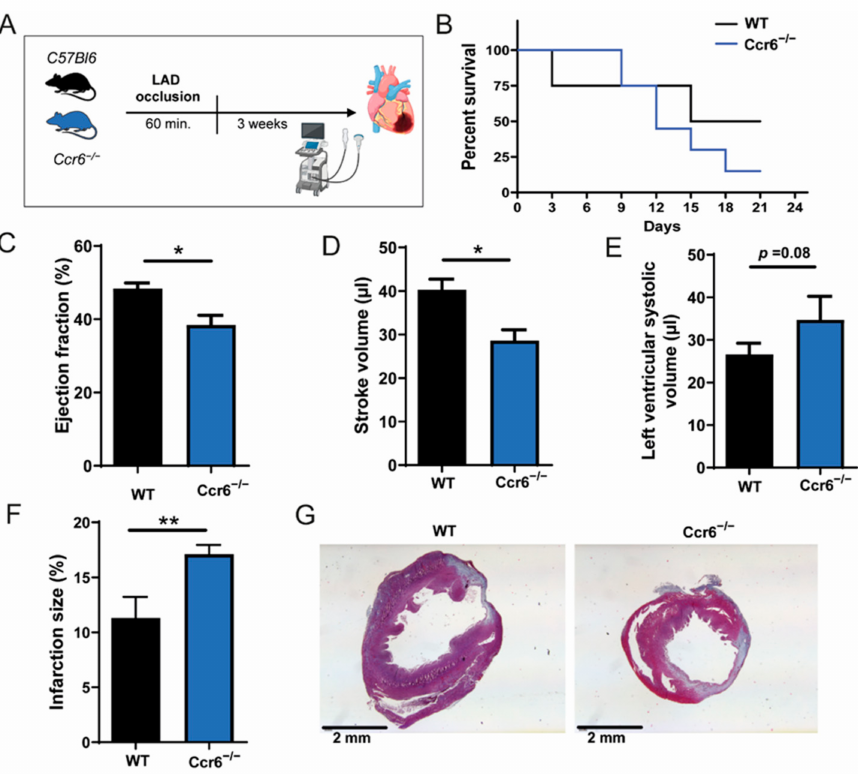
Figure 1. CCR6 deficiency results in decreased cardiac function and increased infarction size after ischemia-reperfusion injury. ( A ) Study design: wild-type and Ccr6 − / − mice were subjected to ischemia-reperfusion injury, echocardiography was performed 3 weeks after injury ( n = 3). Image was created using Biorender.com (Accessed on 2 September 2021). ( B ) Survival curve after ischemia- reperfusion injury. ( C ) Ejection fraction in Ccr6 − / − mice compared to wild-type controls. ( D ) Stroke volume in Ccr6 − / − mice compared to wild-type controls. ( E ) End-systolic volume in Ccr6 − / − mice compared to wild-type controls. ( F ) Infarction size in Ccr6 − / − mice compared to wild-type controls. ( G ) Representative images of Gomori’s 1-step trichrome stain. * p < 0.05, ** p <